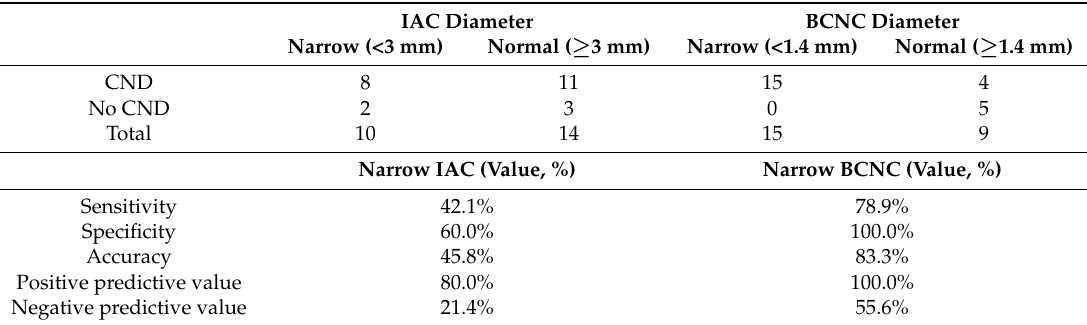
Table 2. Clinical values of the diameters of IAC and BCNC for estimating CND.